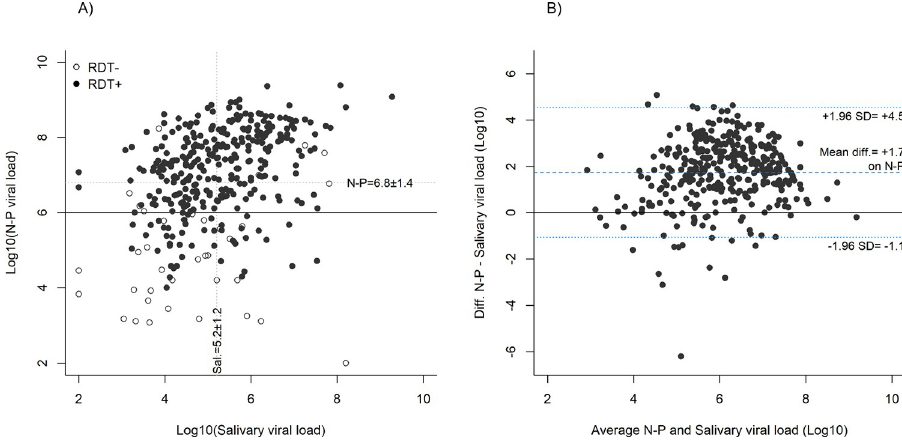
Fig 8. Comparison between log viral loads by nasopharyngeal PCR and saliva PCR. A) Log viral loads in RDT positive (black dots) and negative (white dots) patients. Dotted lines: Mean log viral loads; Black line: Considered threshold for presence of cultivable virus (nasopharyngeal PCR); B) Bland-Altman analysis showing the difference between nasopharyngeal and saliva log viral loads; SD = Standard deviation.